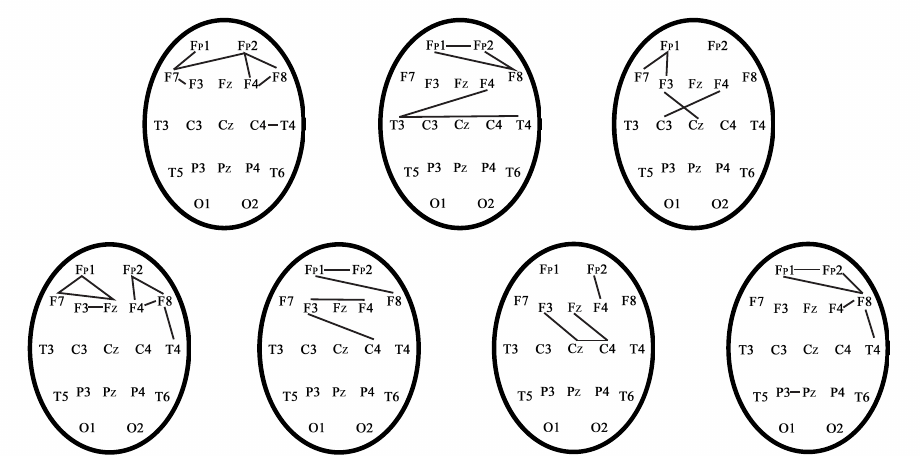
Figure 15. Phase-connected pairs of EEG channels of control subjects during the EEG recording in the CT1 test.